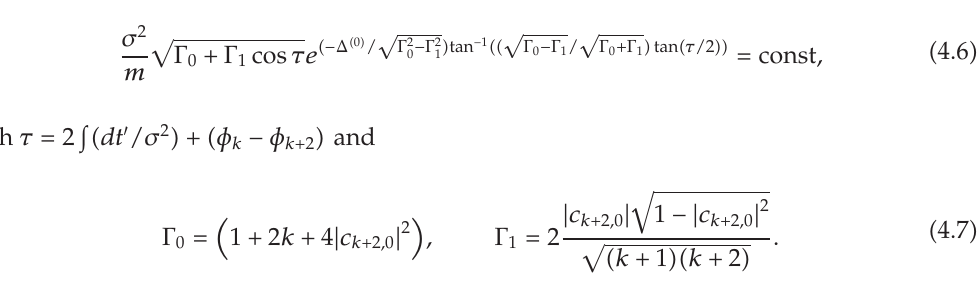
Figure 7: Wigner functions of (cid:4) 1 /